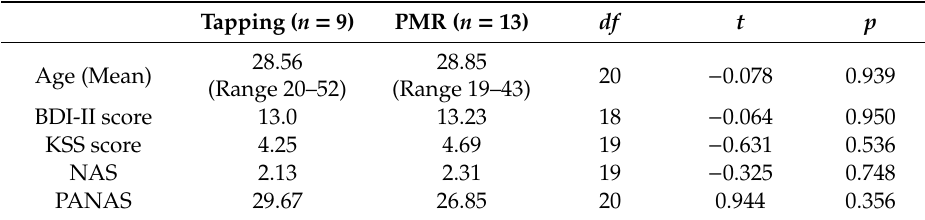
Table 1. Sample description of the two intervention groups at the time of the pretest (baseline). Tapping ( n = 9) PMR ( n = 13) df t p 28.56 28.85 Age (Mean) (Range 20–52)